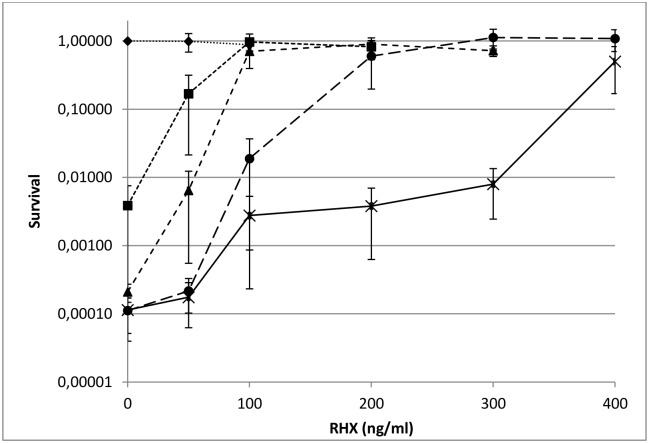
Restoration of Δsmc viability using sublethal concentration of RHX.Δsmc cells were grown in LB at 23°C to exponential growth phase (OD600nm between 0.3 and 0.6), spread on LB plates supplemented with different concentrations of RHX and then incubated 3 to 4 days at 23°C (diamond), 30°C (square), 37°C (triangle), 42°C (circle) and 51°C (cross). Survival rates were calculated relative to the number of colonies formed on LB at 23°C without RHX. The average and standard deviation of three independent experiments is showed. The value without RHX indicate there is no increase of the viability at high temperature for slow growth Δsmc strain. Similar result at 37°C has already been described (17).